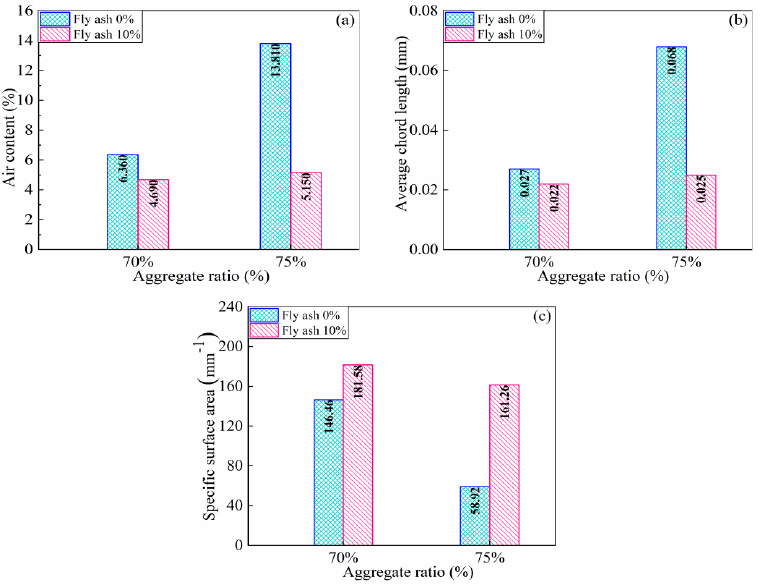
Figure 12. Pore structure of specimens ( a ) air content; ( b ) average chord length; ( c ) specific surface